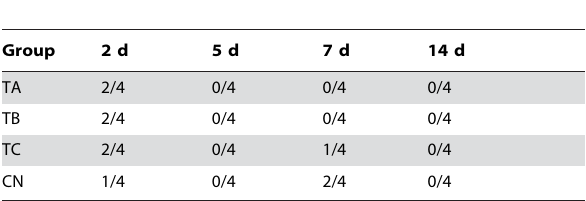
Table 2. Summary of RT-PCR results for viral detection in throat swab samples of monkeys following viral challenge after immunization with the vaccine.